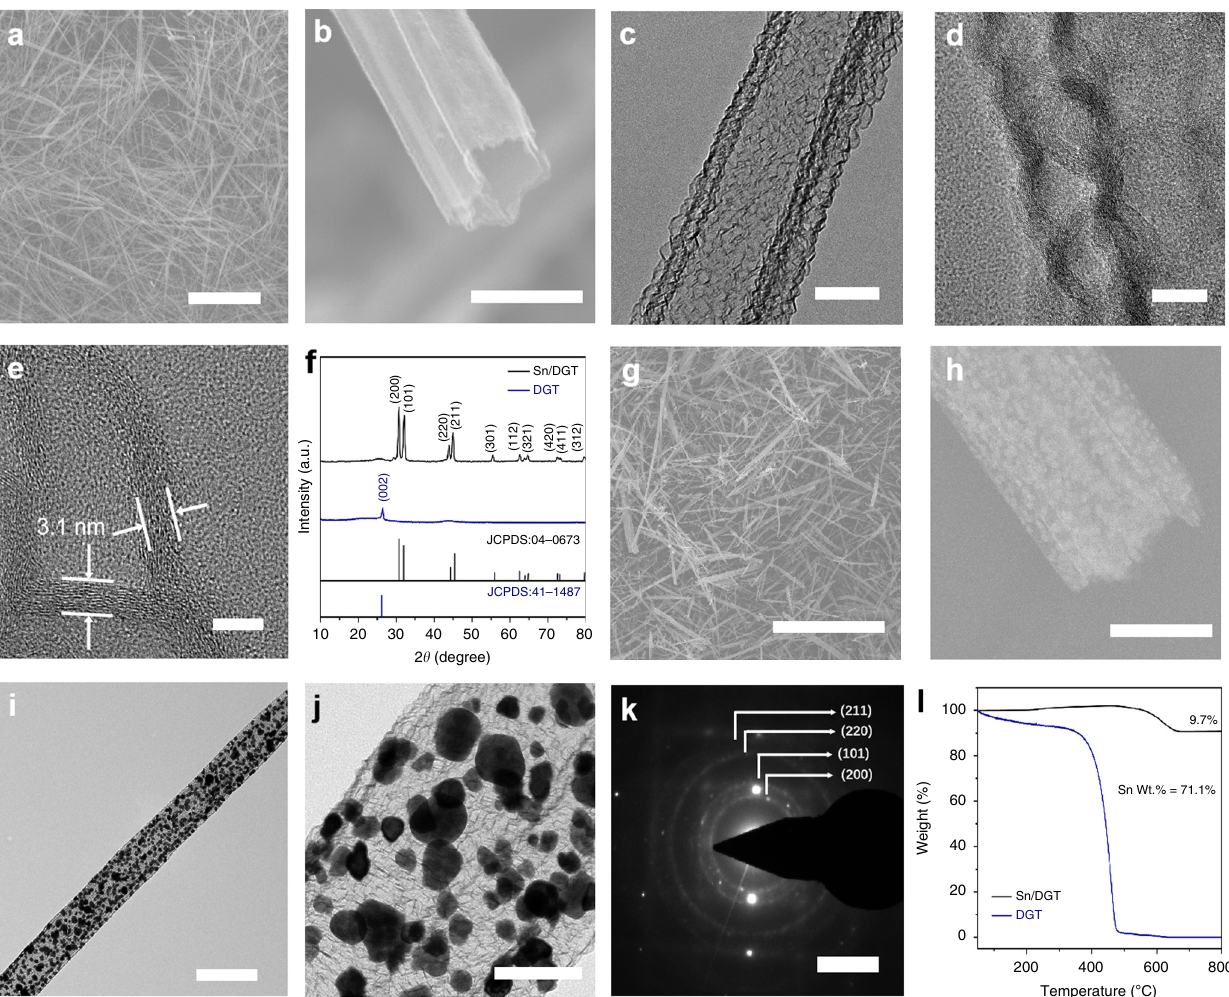
Fig. 2 Morphology and structure of DGT and Sn/DGT. a , b SEM images of DGT. Scale bars: a 10 μ m; b 500 nm, c – e TEM images of DGT. Scale bars: c 200 nm; d 10 nm; e 5 nm, f XRD patterns of DGT and Sn/DGT, g , h SEM images of Sn/DGT. Scale bars: g 10 μ m; h 200 nm, i , j TEM images of Sn/DGT. Scale bars: i 500 nm; j 100 nm, k selective area electronic diffraction of Sn/DGT. Scale bars: k 5 1/nm, and l TGA of DGT and